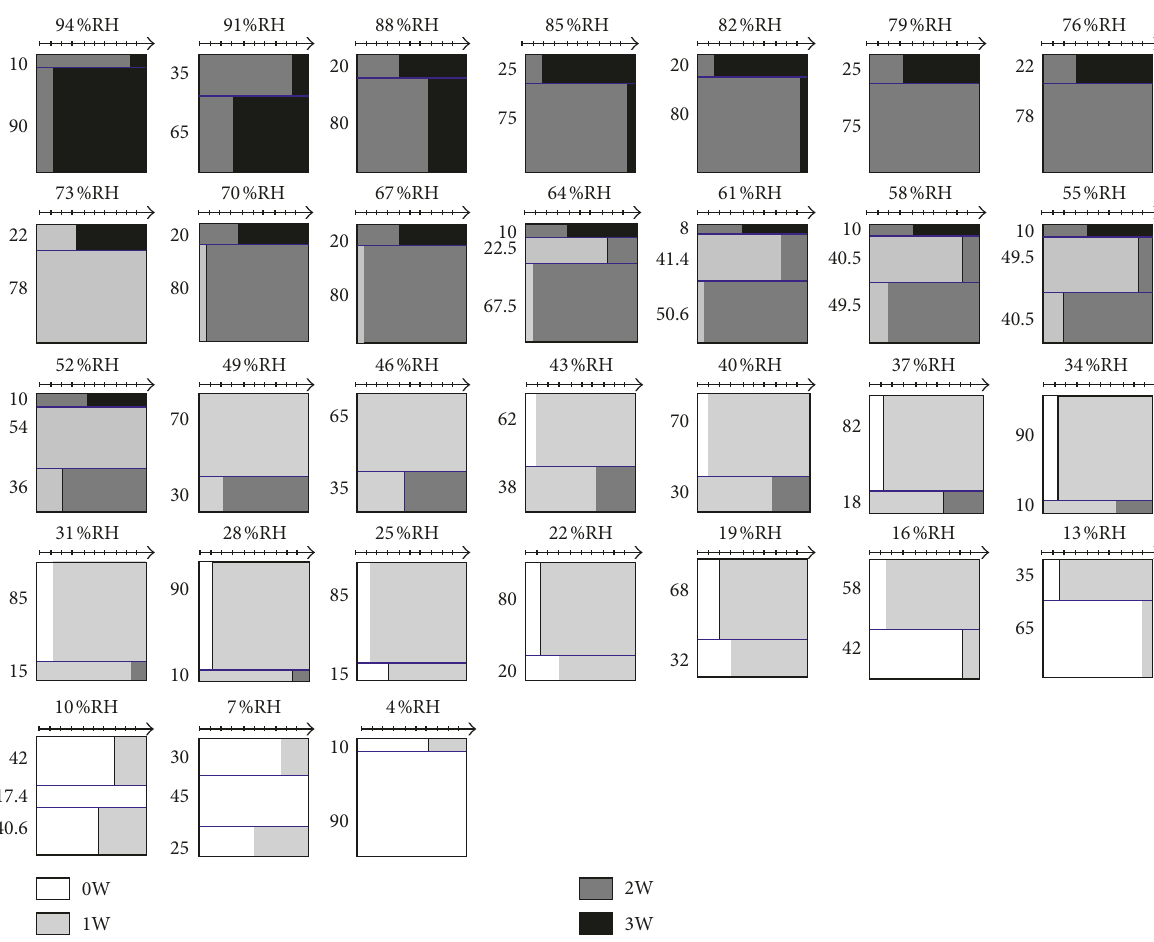
Figure 7: Schematic representation of the MLS used to fit the experimental XRD pattern in the case of the stressed sample along the desorption